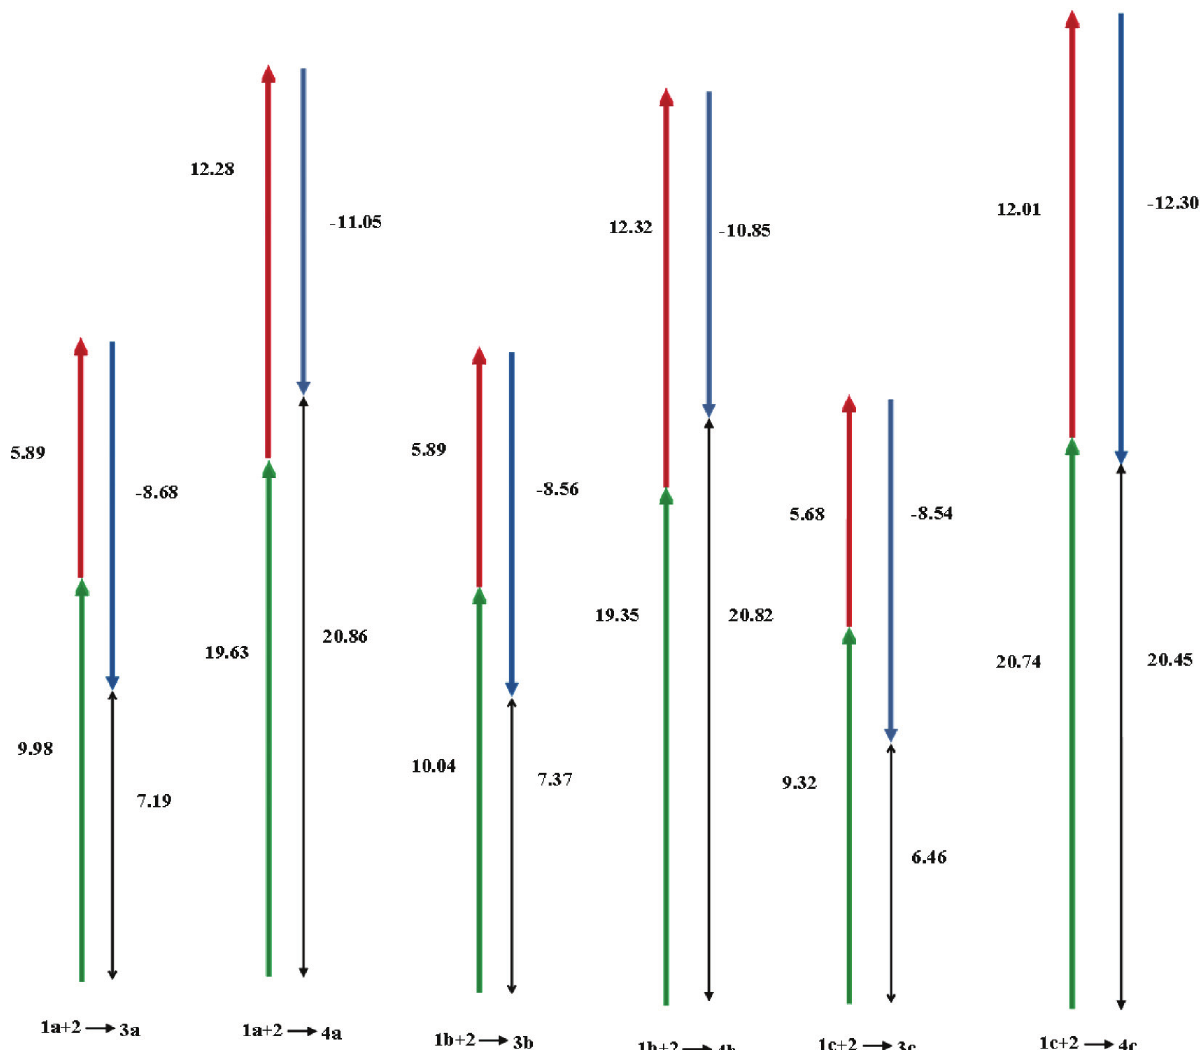
Figure 3. Values of Δ E ++ (black line), Δ E ++